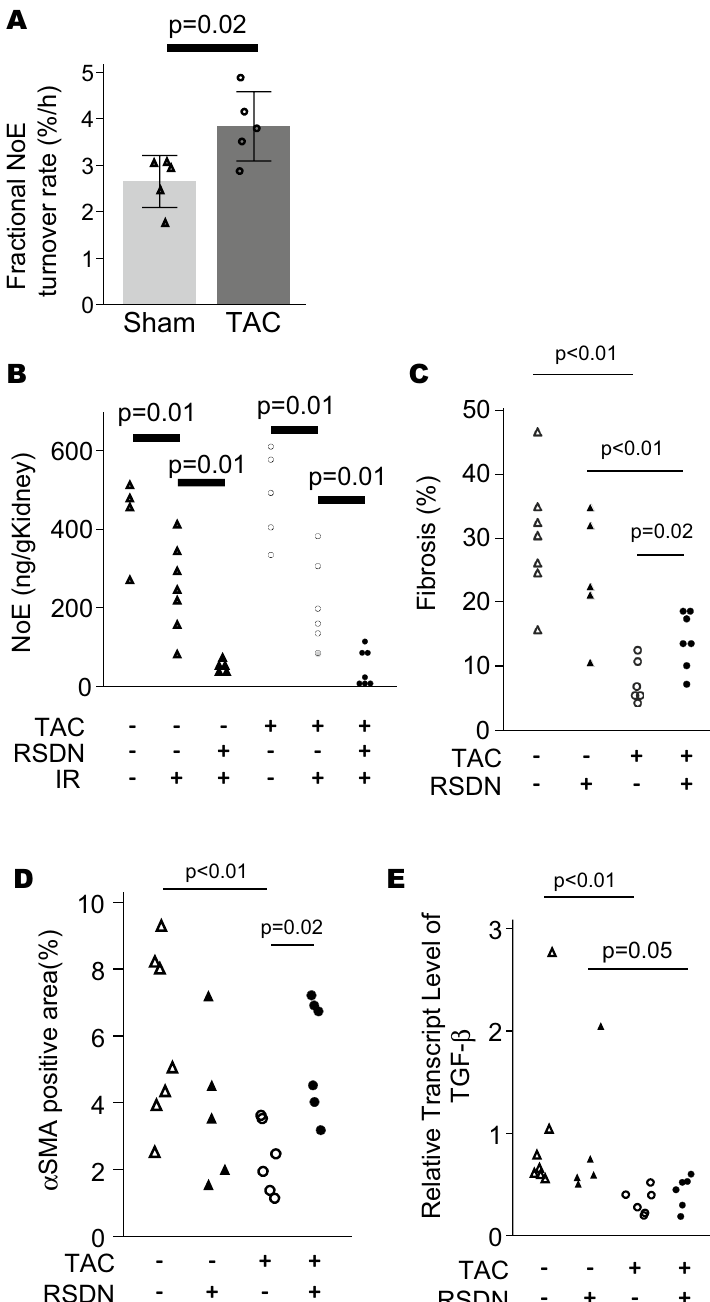
Figure 7. Renal sympathetic denervation worsened renal fibrosis after IR in TAC mice (Experiment 3). ( A ) Fractional Norepinephrine (NoE) turnover rate (%/h), ( B ) NoE concentration in kidney (ng/g kidney), ( C ) Quantified renal fibrotic areas and ( D ) α-SMA positive area, and ( E ) mRNA level of TGF-β are shown (n = 5–7 per group). # p < 0.05. In ( B ), open triangle represents non-TAC mice without RSDN and IR; gray triangle non- TAC + IR mice without RSDN; filled triangle non-TAC + IR with RSDN; open circle, TAC mice without IR and RSDN; gray circle, TAC + IR mice without RSDN; filled circle, TAC + IR + RSDN mice. In ( C–E ), open triangle represents non-TAC + IR mice without RSDN; filled triangle non-TAC + IR with RSDN; open circle, TAC + IR mice without RSDN; filled circle, TAC + IR + RSDN mice. All graphs were created using JMP 14.0 software (SAS Institute Inc., Cary,